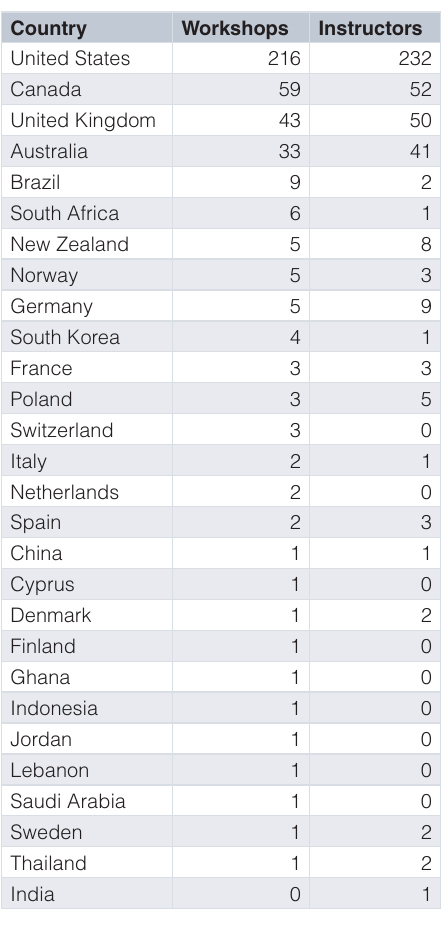
Table 3. Workshops and Instructors by Country (October